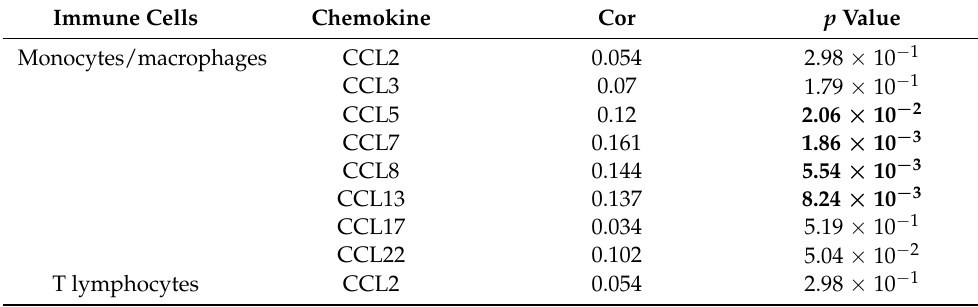
Figure 8. The relationship of immune cell infiltration with the EZH2 level in HCC. ( A ) The infiltration level of various immune cells under different copy numbers of EZH2 in HCC. ( B , C ) The correlation of the EZH2 expression level with neutrophil, cancer-associated fibroblast (CAF), dendritic cell, B cell, CD8+ T cell, and macrophage infiltration levels in HCC. Table 1. The correlation between EZH2 expression and chemotactic activity for immune cells.